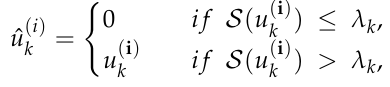
Figure 6. Hypothesis testing based signal and noise detection: F plotted along with of F i s ( t ) of signal coefficients (dashed line) and the EDF F i η ( t ) of noise coefficients (dotted